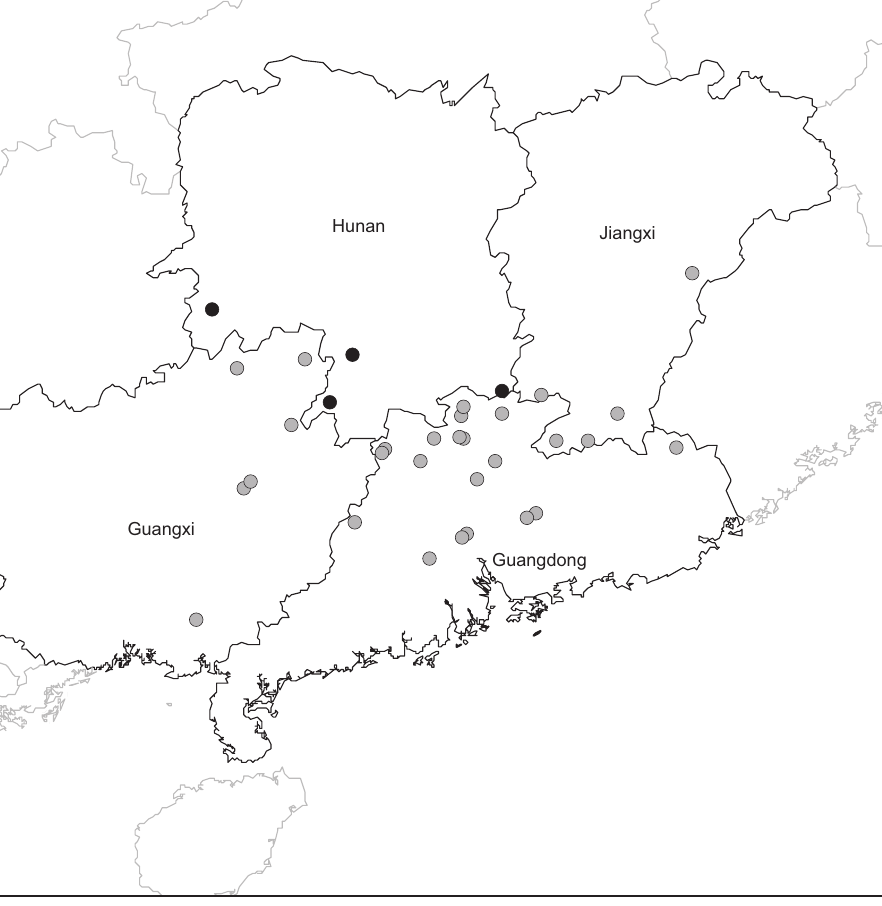
Figure 3. Distribution of P. kwangtungensis in China. Grey circles indicate localities taken from her- barium specimens. Black circles indicate populations observed by Yu from